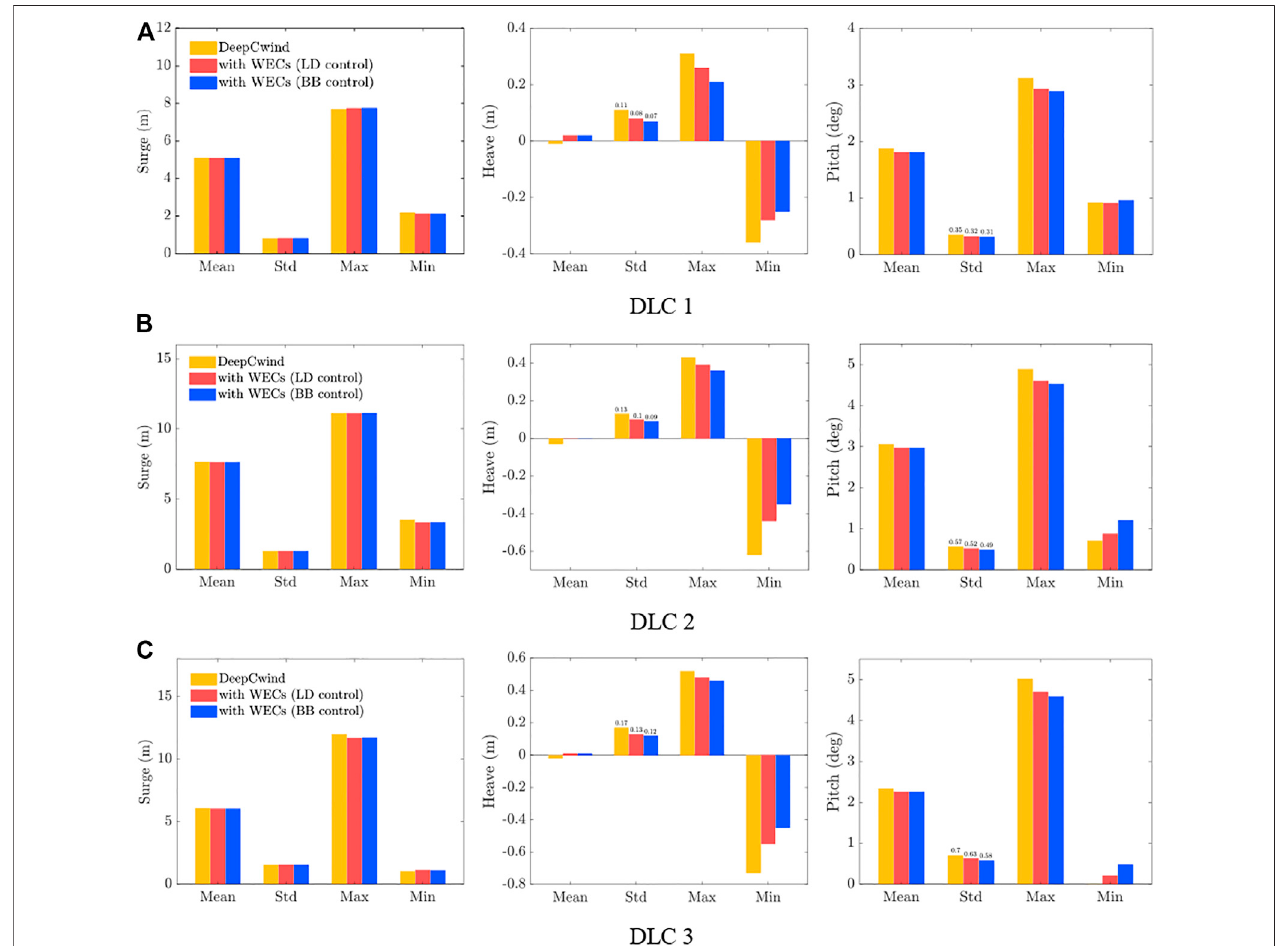
FIGURE 14 | Statistical results of platform motions with different PTO control strategies. (A) DLC 1. (B) DLC 2. (C) DLC 3.